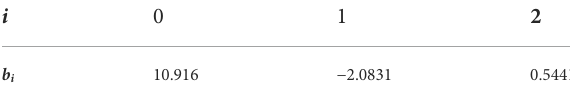
TABLE 2 Values of the constants used in Eq. 18.